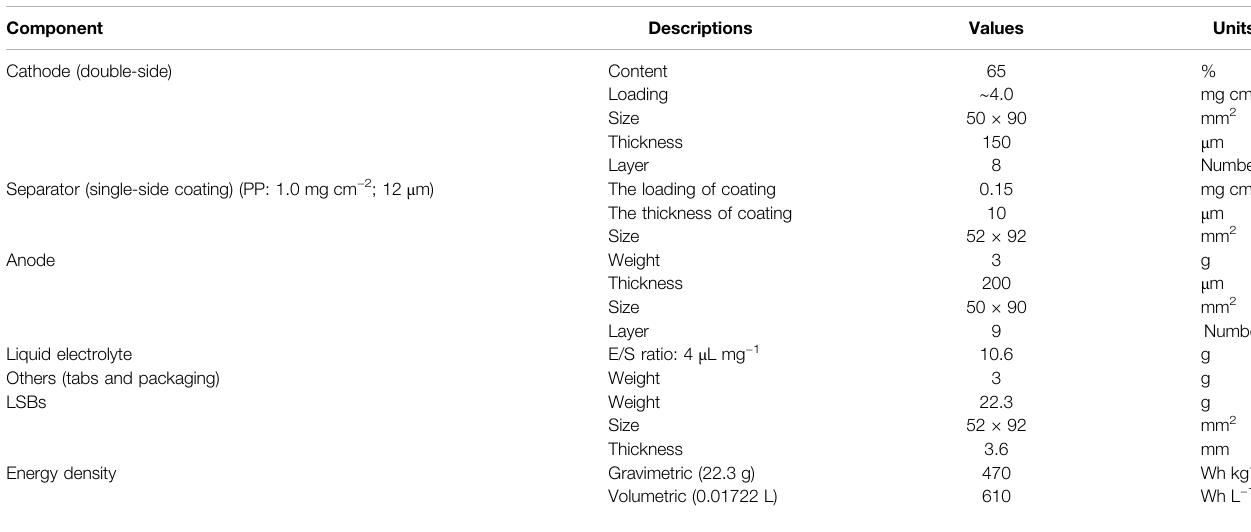
TABLE 2 | The cell parameters and energy density of fi ve Ah Li-S pouch cells.